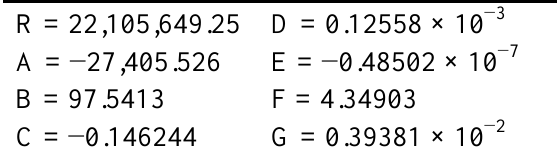
Table 1. Coefficients used to compute the psychometric data